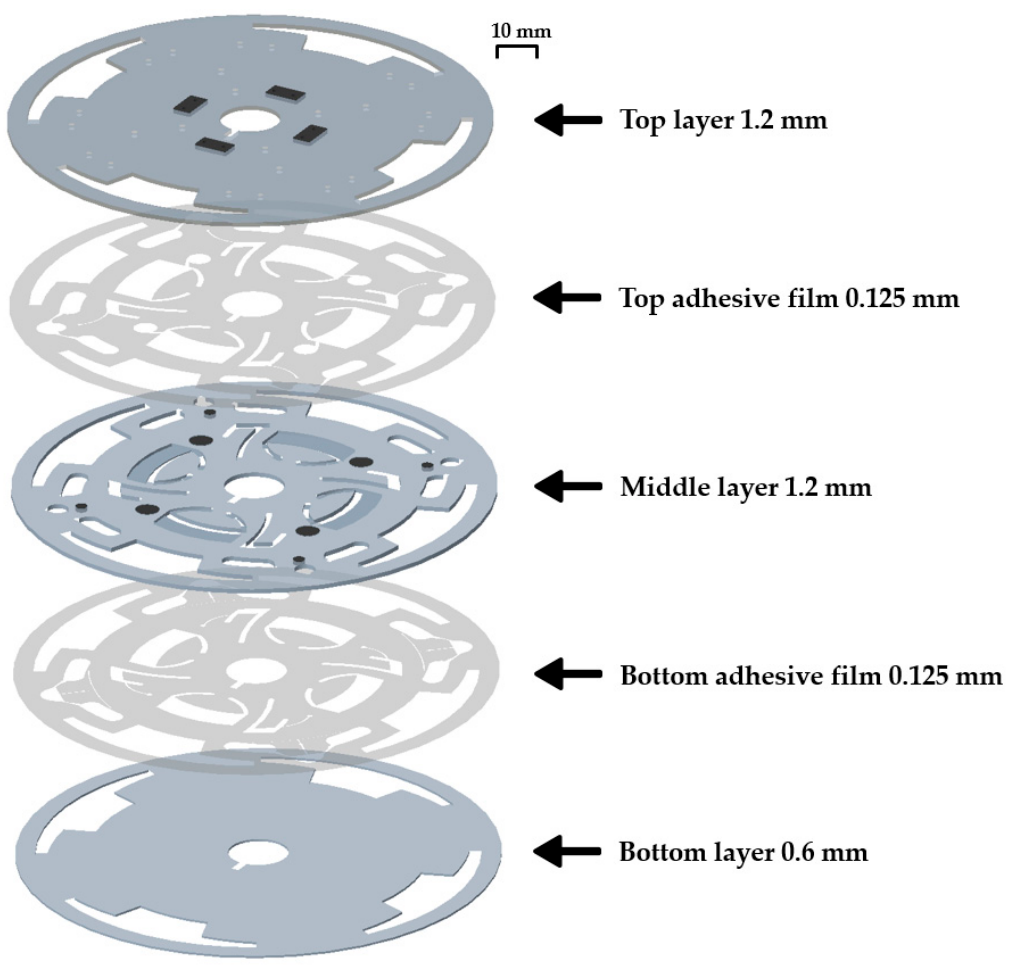
Figure 2. LOD layer assembly schematic. The top and middle layers are bonded with the top adhesive film; the middle and bottom layers are bonded with the bottom adhesive film.